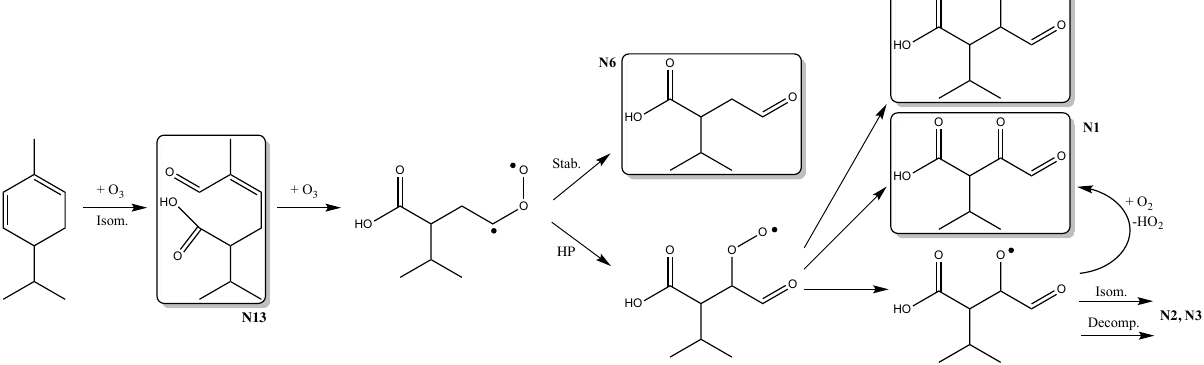
Figure 2. Simplified ozonolysis pathway outlining the formation of some major species detected in negative mode ESI. Analogous structures can additionally be traced by varying the order of addition to the two double bonds and/or which CIs participate in the hydroperoxide (HP) and stabilisation channels,